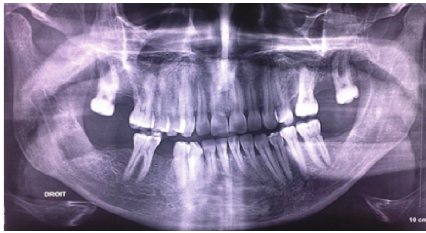
Figure 4: A 3-month postoperative panoramic